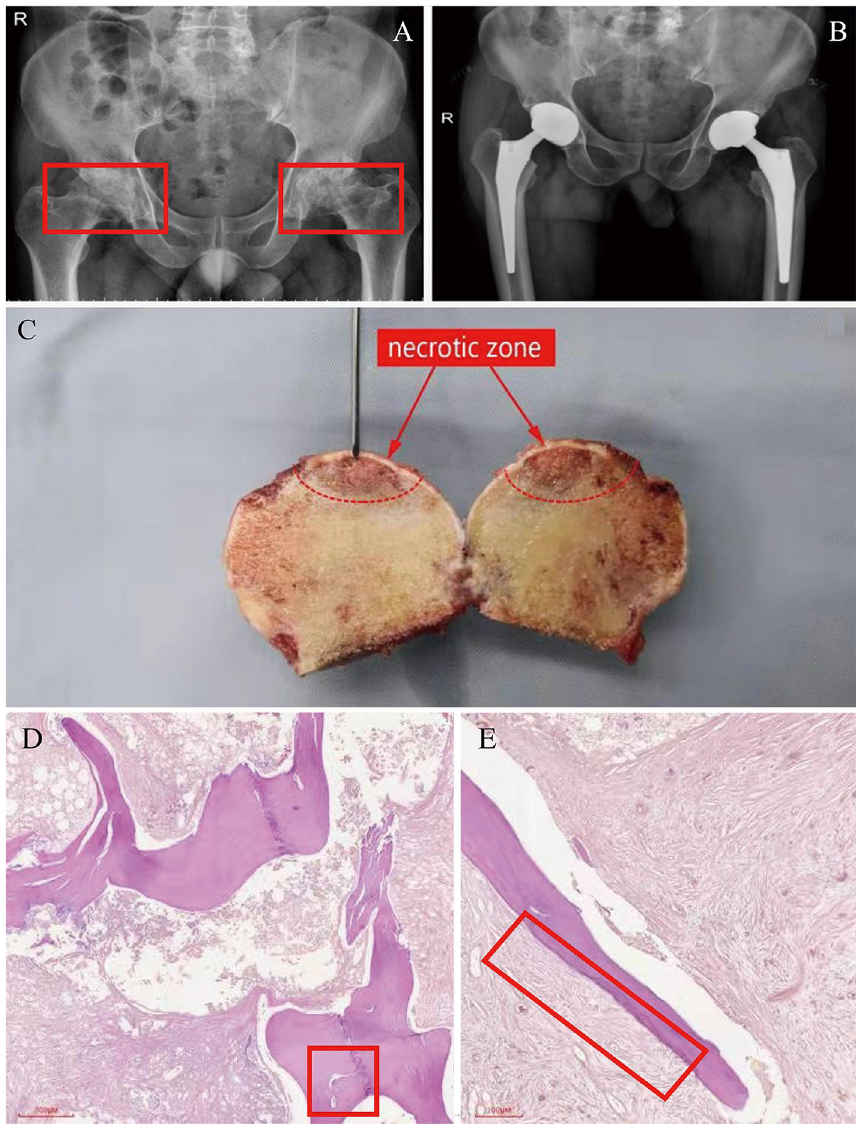
Figure 4. Imaging system for clinical diagnosis. ( A ) Preoperative pelvic frontal radiograph (X-ray). Bilateral femoral heads were flat, with multiple cystic low-density shadows and narrowed joint space (red boxes on both sides) ( B ) Implanted prosthesis on pelvis orthographic film (X-ray) ( C ) Diseased tissue (with a red arrow pointing to necrosis). ( D ) Morphological abnormality in bone trabecular (left red frame) (40 ×). ( E ) Bone trabecular necrosis (right red box) (100